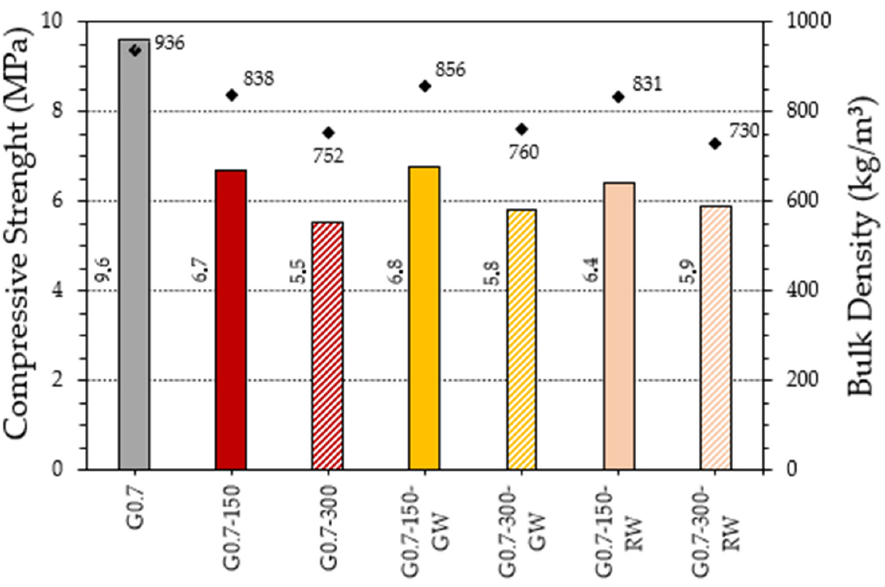
Figure 12. Compressive strength of precast blocks and bulk